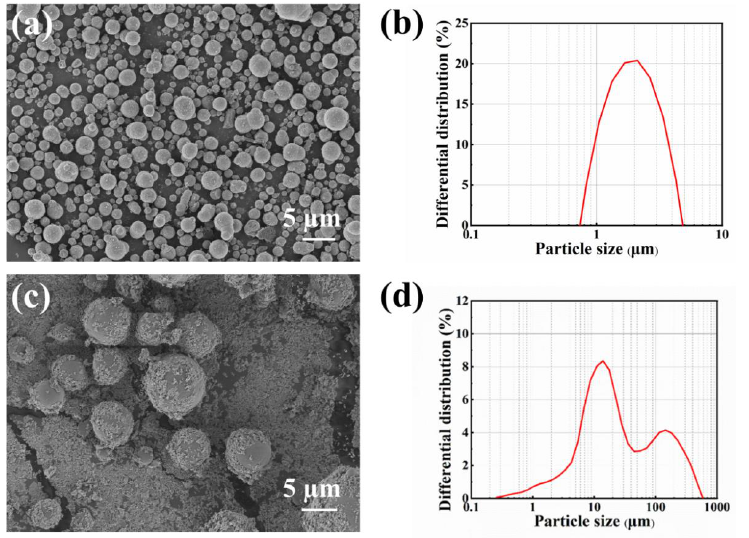
Figure 2. SEM images and particle size distribution curves of the functional powders. ( a , b ) Absorbing fillers, ( c , d ) head-conducting powders. Figure 2b,d shows the particle size distribution curve of the fillers measured by par- ticle size distribution instrument. The median diameter (D50) of the absorbent is 1.76 μm,